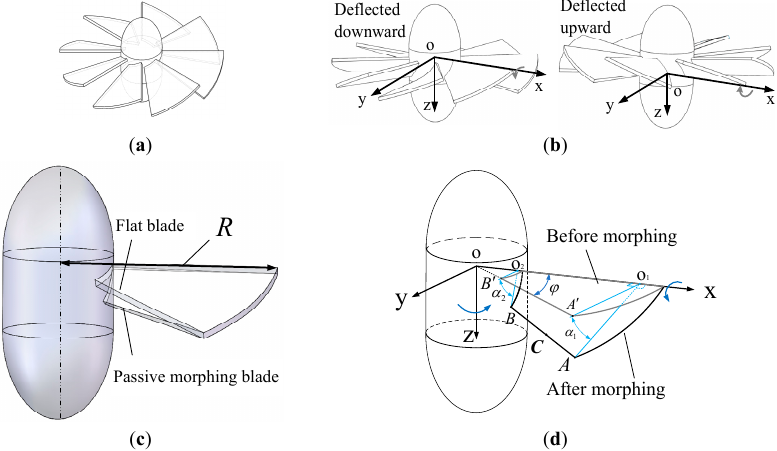
Figure 4. ( a ) Flat ‐ blade group; ( b ) passive morphing ‐ blade group; ( c ) difference between passive morphing blade and flat blade.; ( d ) passive morphing ‐ blade deflection principle.